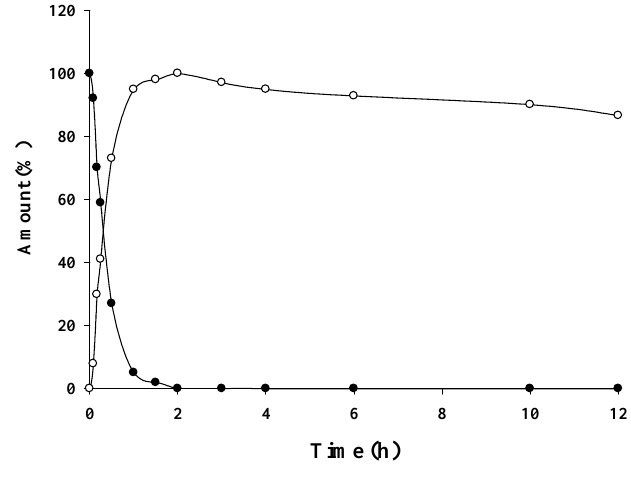
Figure 4. Release profiles of curcumin ( 1 ; ○ ) from curcumin diethyl disuccinate ( 5 ; ● ) in human plasma at 37